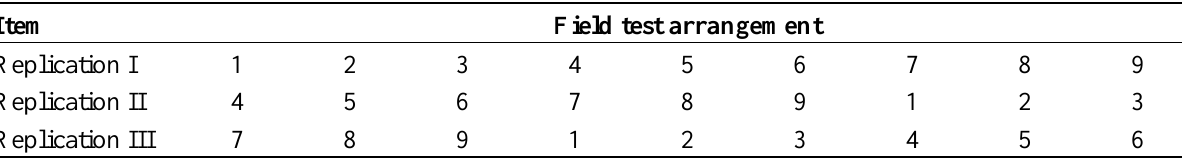
Table 7. Field arrangement of IAA and